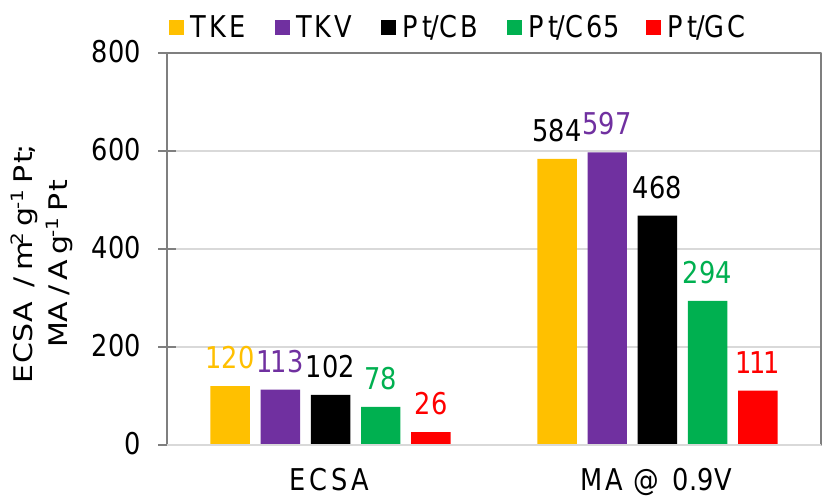
Figure 4. Comparison of mass activities (at 0.9 V vs. RHE) and ECSA of the catalysts at 50 mV s −1 voltage scan rate in 0.1 M HClO 4 at RT.